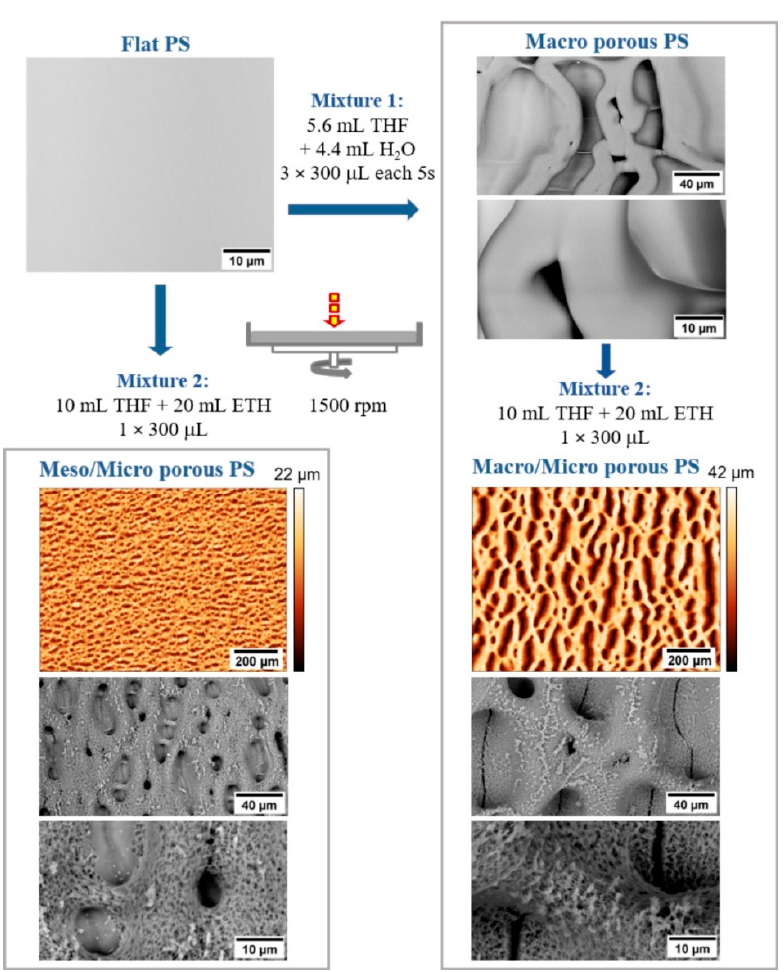
Figure 2. Hierarchically structured PS surfaces prepared by one- or two-step deposition of mixed solutions. Images from SEM and optical profilometer. solutions. Images from SEM and optical